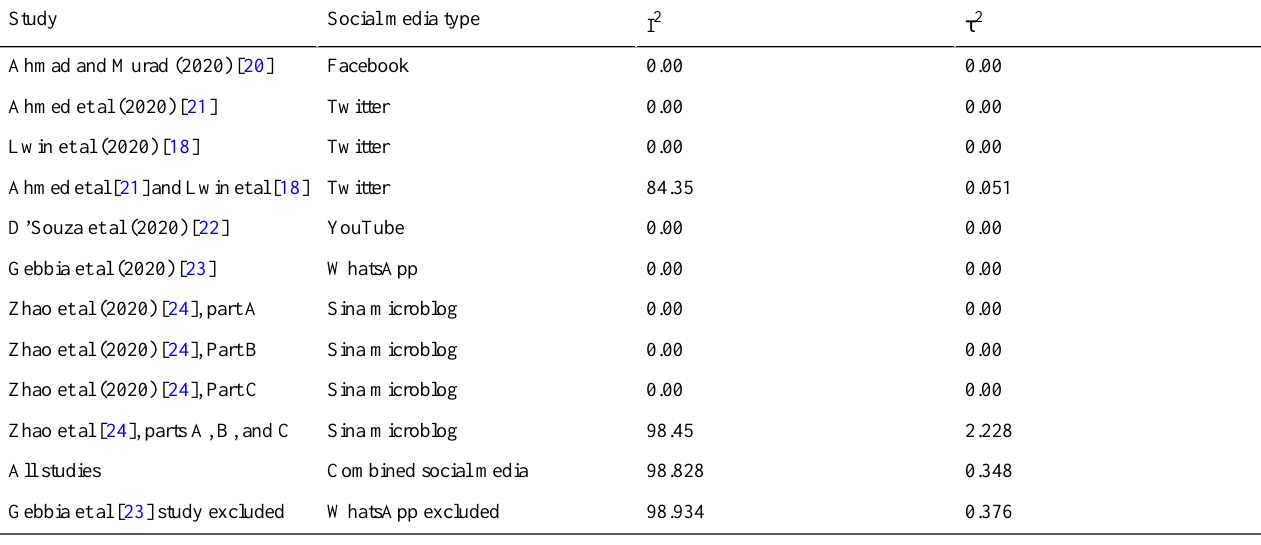
Table 5. Intrinsic heterogeneity in each included study or social media type